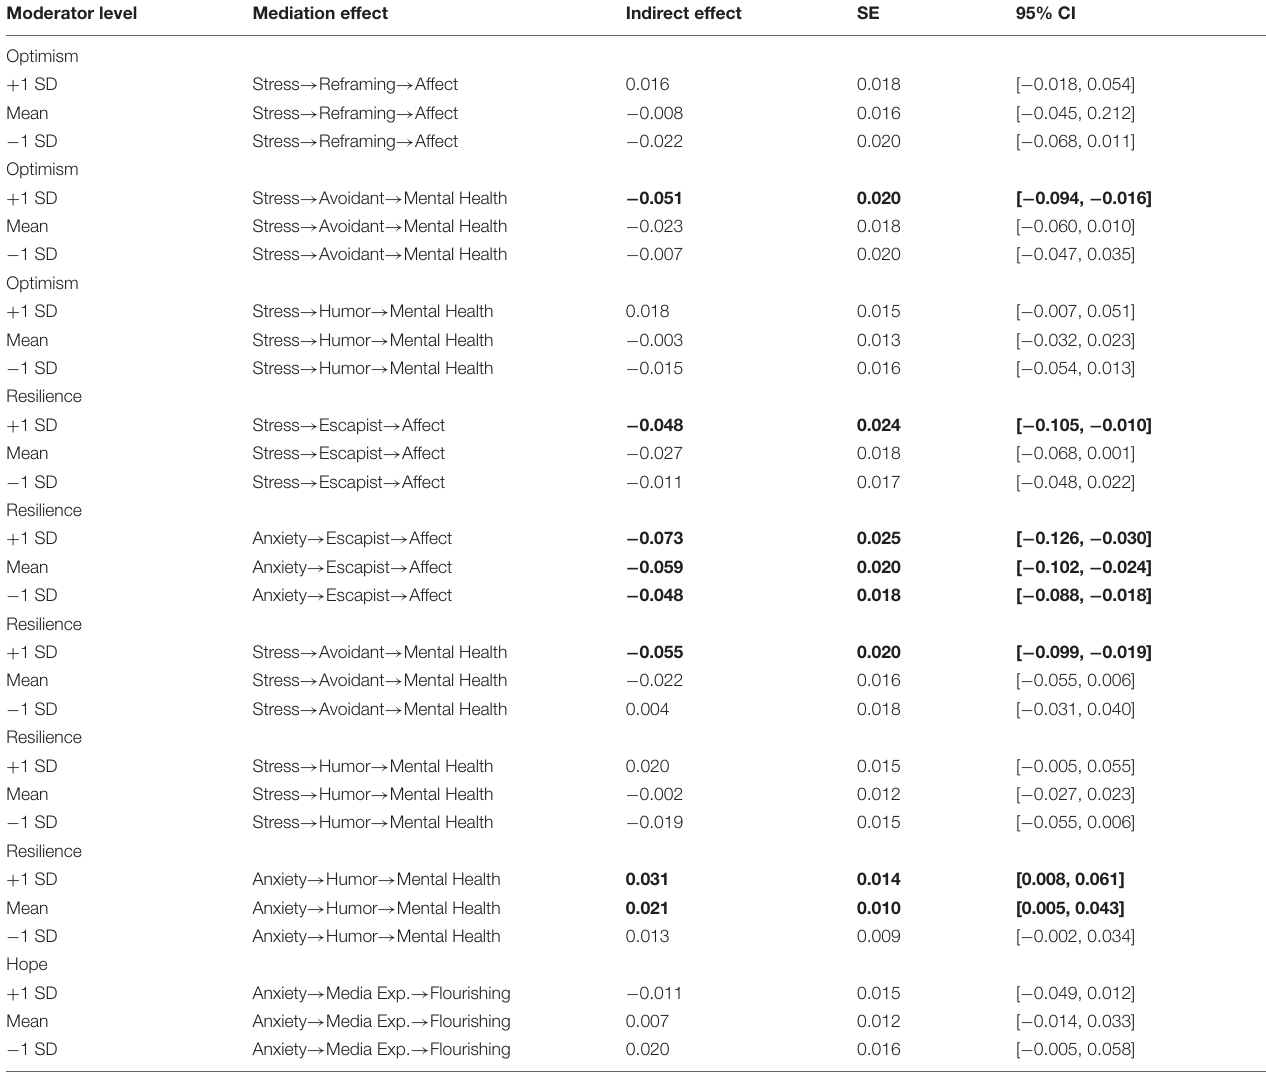
TABLE 8 | Significant moderated mediation